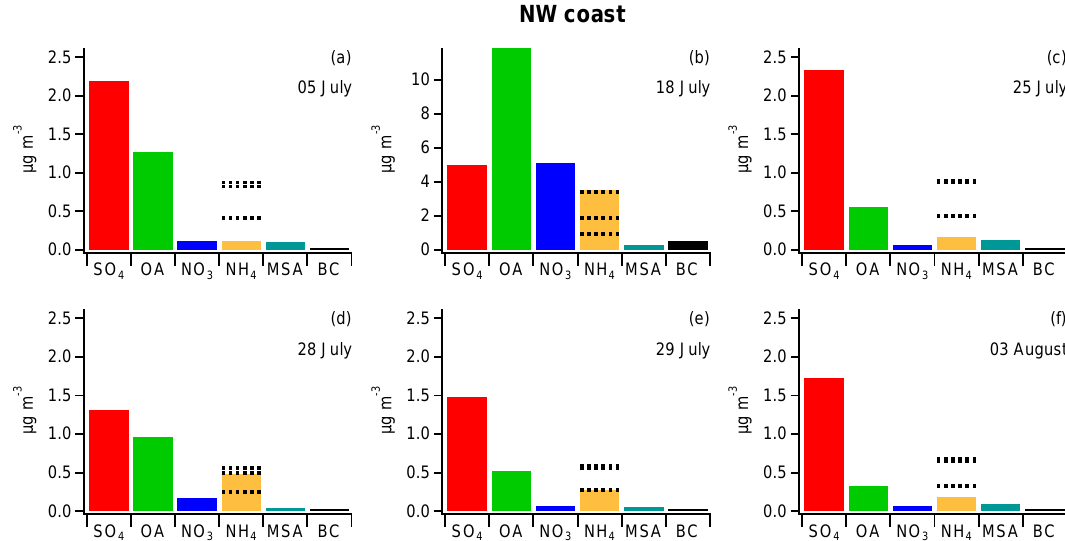
Figure 4. Aerosol composition measured over the NW coast during the six case study flights. The definitions of each chemical species are given in Sect. 2.1. The lower and middle dashed lines show the concentration of NH 4 required to neutralise the SO 4 to ammonium bisulfate and sulfate respectively. The top dashed line shows the concentration of NH 4 required to fully neutralise all measured inorganic components. The reader should consult in Sect. 3.3.4 for discussion of the NO 3